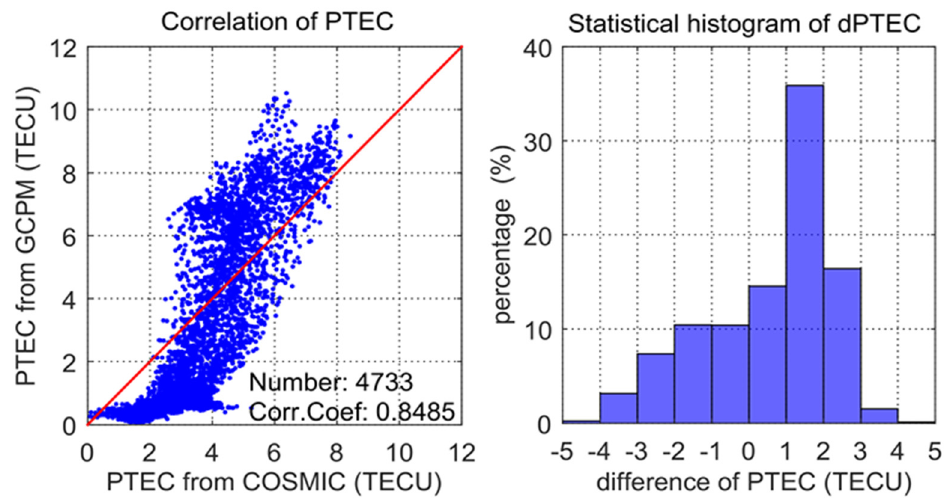
Figure 4. Comparison and difference distribution of PTEC from topside GPS observations of COSMIC and GCPM in January 2008.